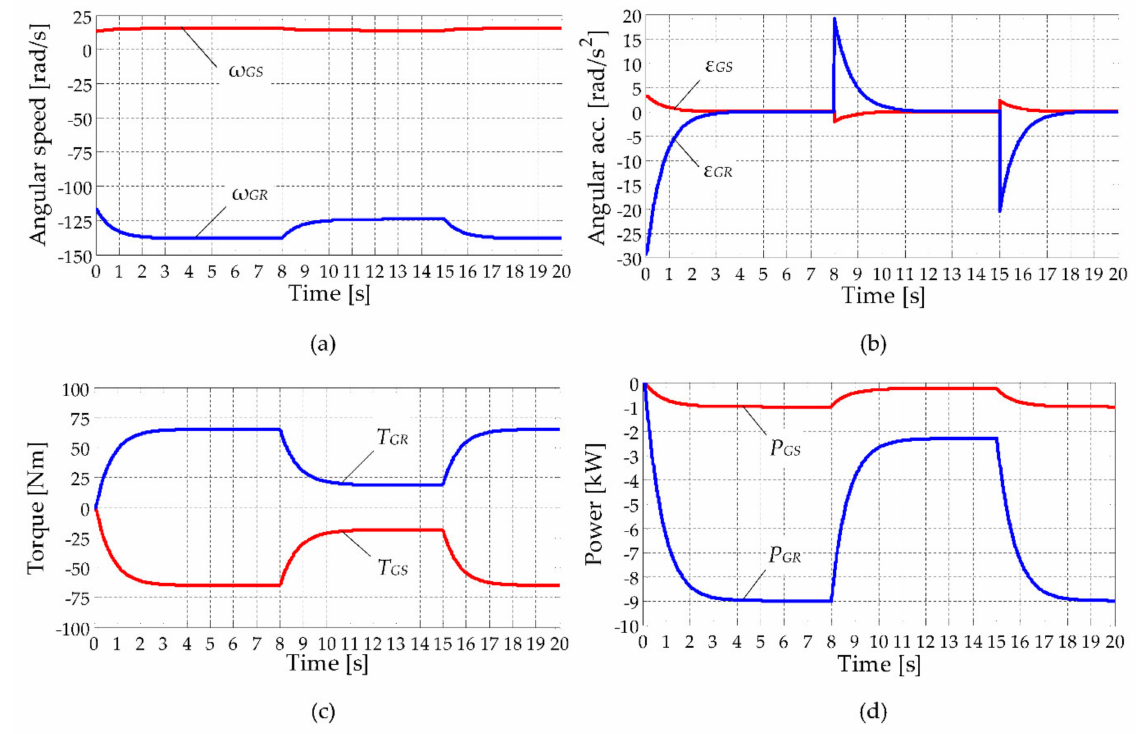
Figure 7. The dynamic behaviour of the generator rotor GR and stator GS in relation to wind speed modification: ( a ) angular speed; ( b ) angular acceleration; ( c ) torque; and ( d ) mechanical power.